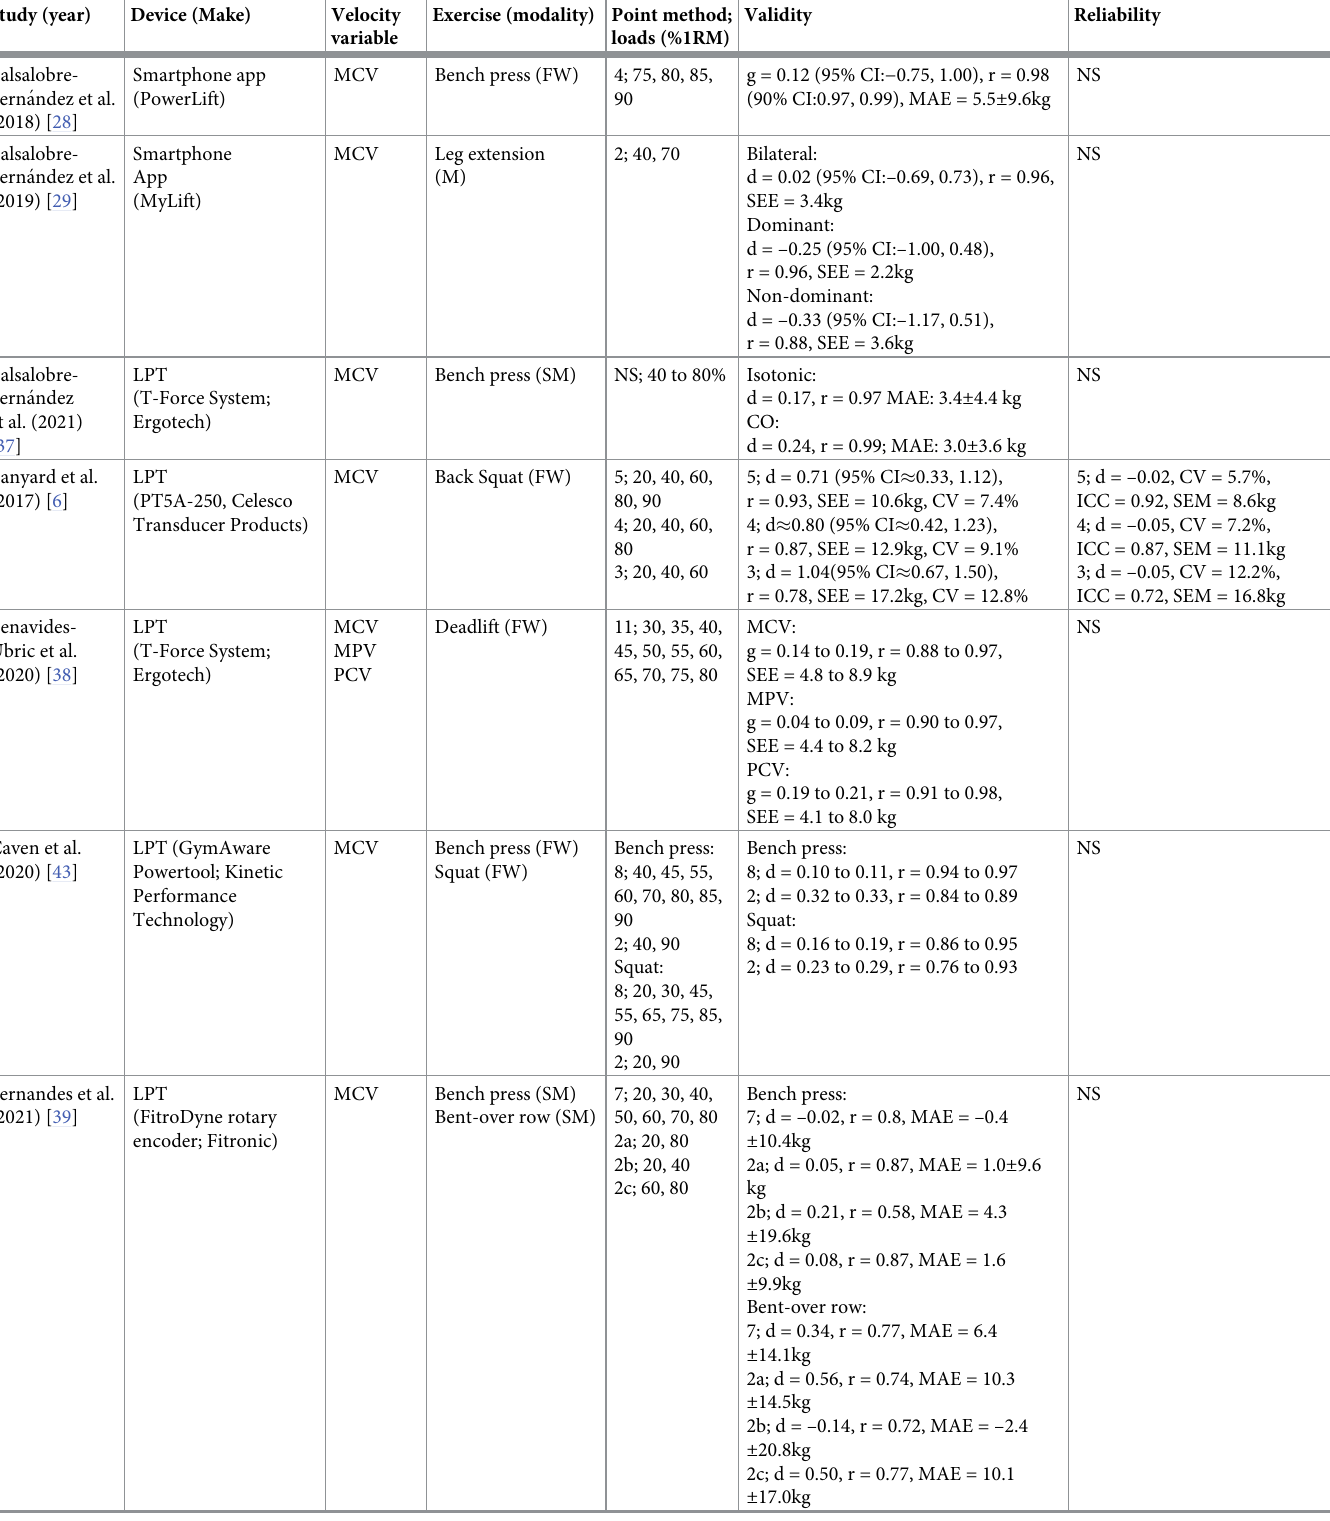
Table 4. Summary of results utilising the minimal velocity threshold prediction